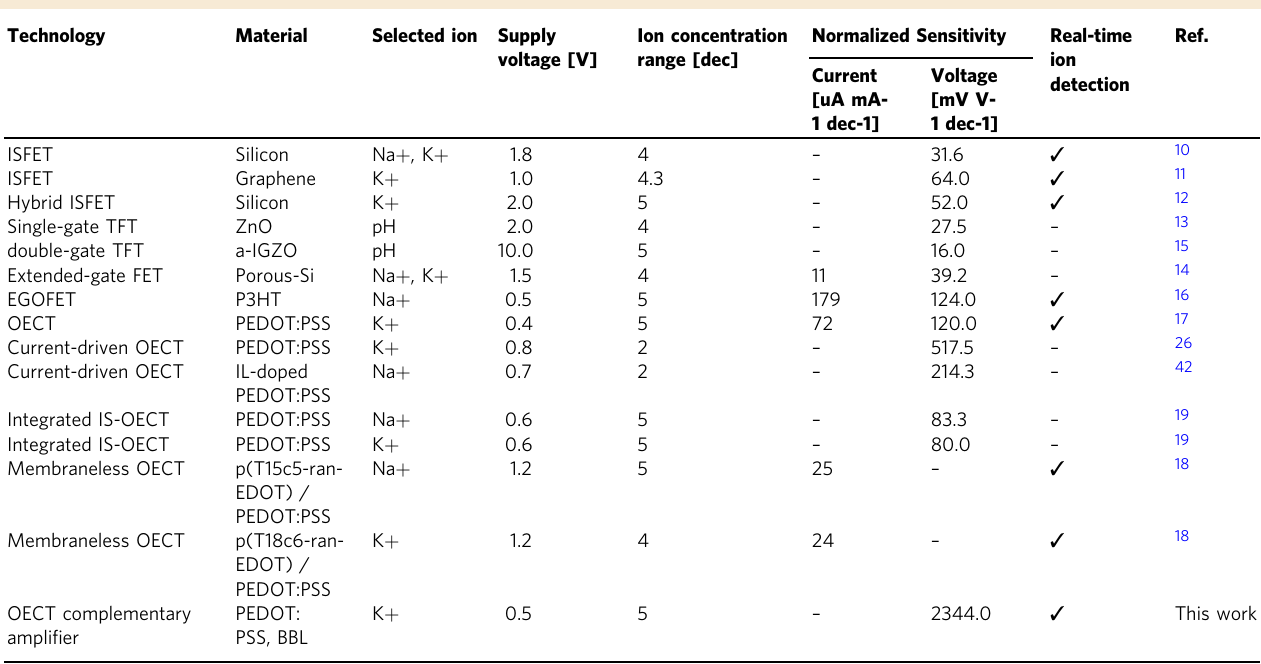
Table 1 Sensing performances